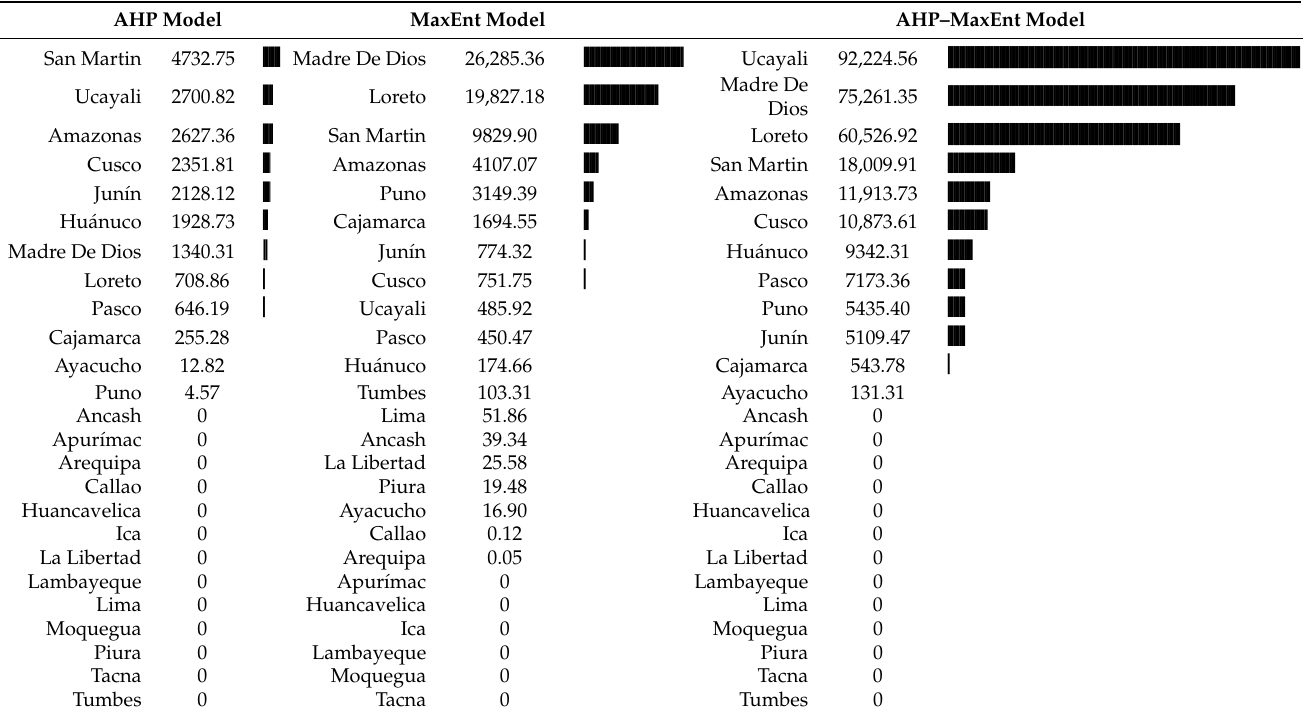
Figure 5. Land suitability map for cocoa cultivation in Peru, AHP model. Table 4. ‘Highly suitable’ area (km 2 ) of land suitability for cocoa cultivation in Peru, based on regions and modeling approaches.